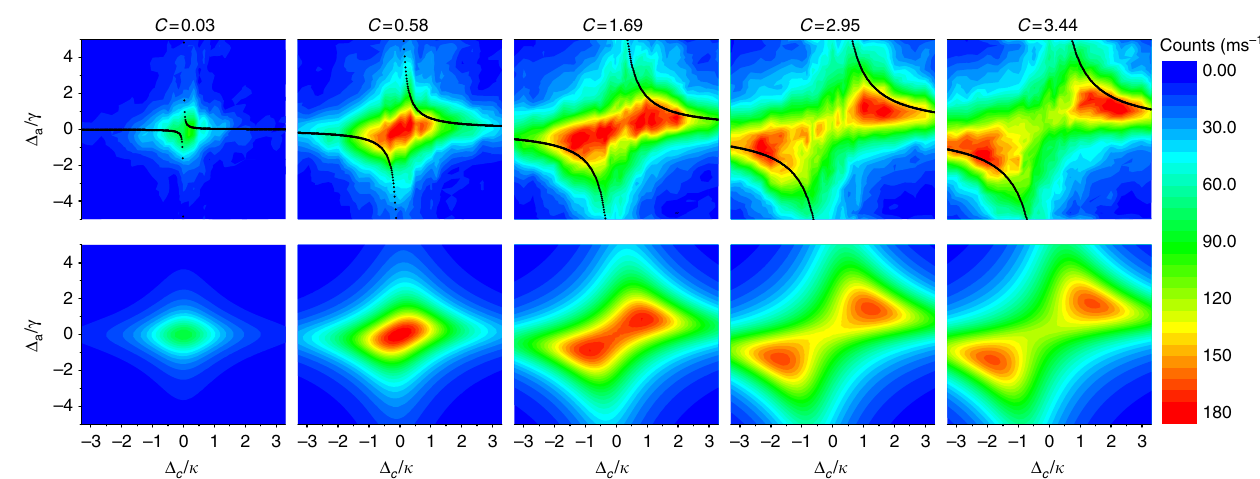
Figure 4 | Probing the system by driving the atoms. Two-dimensional scans of the cavity emission signal in the experimental configuration of Fig. 2b as a function of the detunings D c and D a for different values of the cooperativity C . Upper row: experimental spectra. The colour scale reflects the measured number of counts per ms. Every spectrum contains 31 (cid:7) 31 points, each averaged over 40 experimental realizations. The black curves show the eigenvalues of the undamped Hamiltonian. Lower row: theory of equations (7) and (8) after fitting to the data in the upper row with j ¼ 0. The fitting parameters are C and the amplitude. glued onto the tip of a cleaved single-mode optical fibre. This mirror serves as the input–output coupling mirror. The second mirror is one of an array of approximately spherical micro-mirrors with 185 m m radius of curvature on an etched and dielectric-coated silicon wafer. The cavity length is tuned around 127 m m using a shear piezo on which the fibre mirror is mounted, and is stabilised with a side-of-fringe technique using light from a single-frequency Ti:sapphire laser (Coherent, MBR-110) operating at 800nm. The wavelengths of both locking and probing lasers are monitored with a wavemeter (HighFinesse, WS6). The cavity finesse varies slightly throughout the measurements presented here due to a slow drift in the mirror alignment. The finesse (linewidth k /(2 p )) is 260 (2.2GHz) in Fig. 3, and 180 (3.2GHz) in Fig. 4. The fringe contrast, defined by 1 (cid:2) (min power)/(max power) throughout a cavity scan, is above 95% for all of the measurements. Near-resonant signal light from the cavity is separated from the locking light and incoming probe light using a 90/10 beam splitter and a series of dichroic filters, and detected on a single-photon counting module (Perkin-Elmer, SPCM-AQR-14). The detected counts are corrected for dead time at high flux rates with a polynomial formula as specified by the manufacturer.